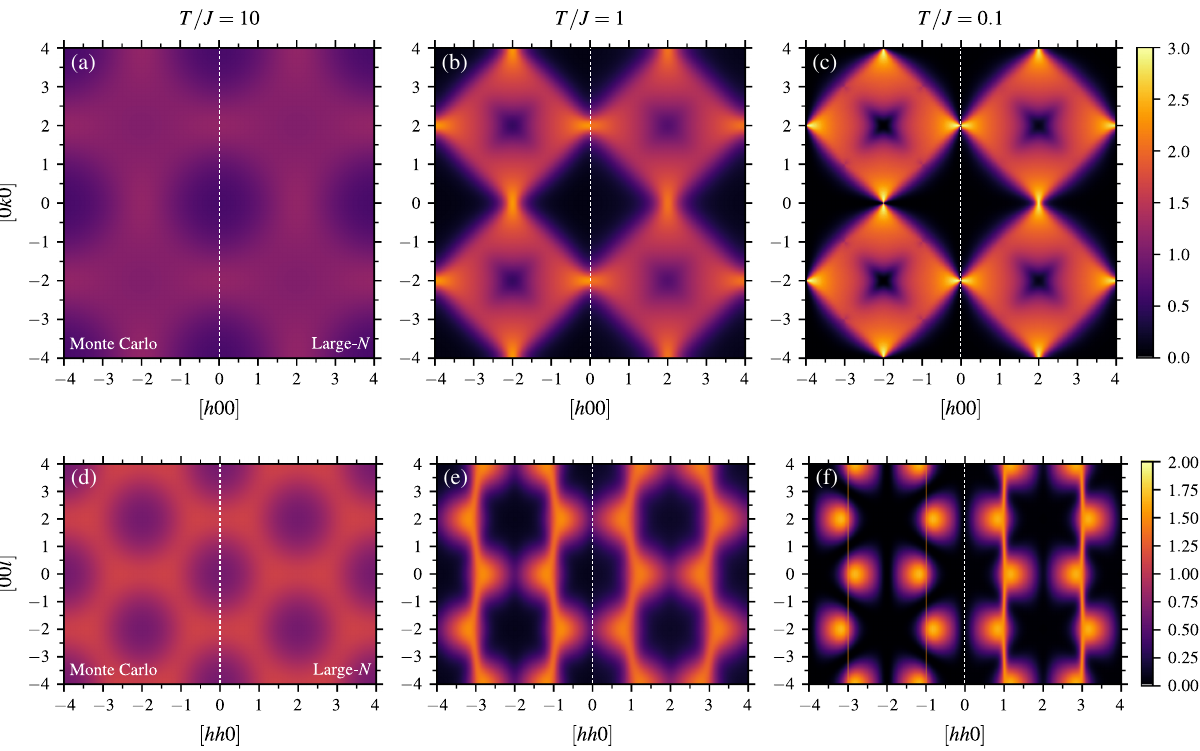
FIG. 5. Spin-spin correlation functions S ð q Þ [from large- N (right) and Monte Carlo (left)] of spin-ice films of thickness L ¼ 1 , for temperatures (a,d) T=J ¼ 10 , (b,e) T=J ¼ 1 , and (c,f) T=J ¼ 0 . 1 in the (a – c) ½ hk 0 (cid:3) and (d – f) ½ hhl (cid:3) planes. Monte Carlo simulations were performed with L ⊥ ¼ 64 . For the temperatures considered, the large- N results are (effectively) in the thermodynamic limit ( L ⊥ → ∞